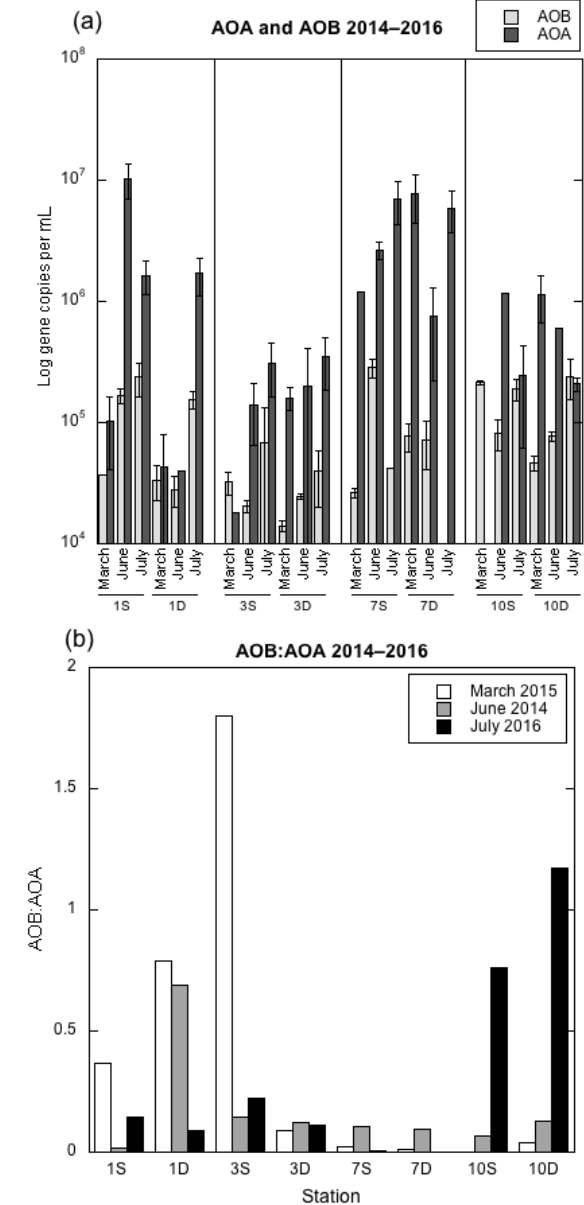
Figure 4. Ammonia-oxidizing organism population characteristics. (a) Ammonia oxidizer abundance (DNA) ± 1 standard deviation. (b) Ratio of abundance of AOB to